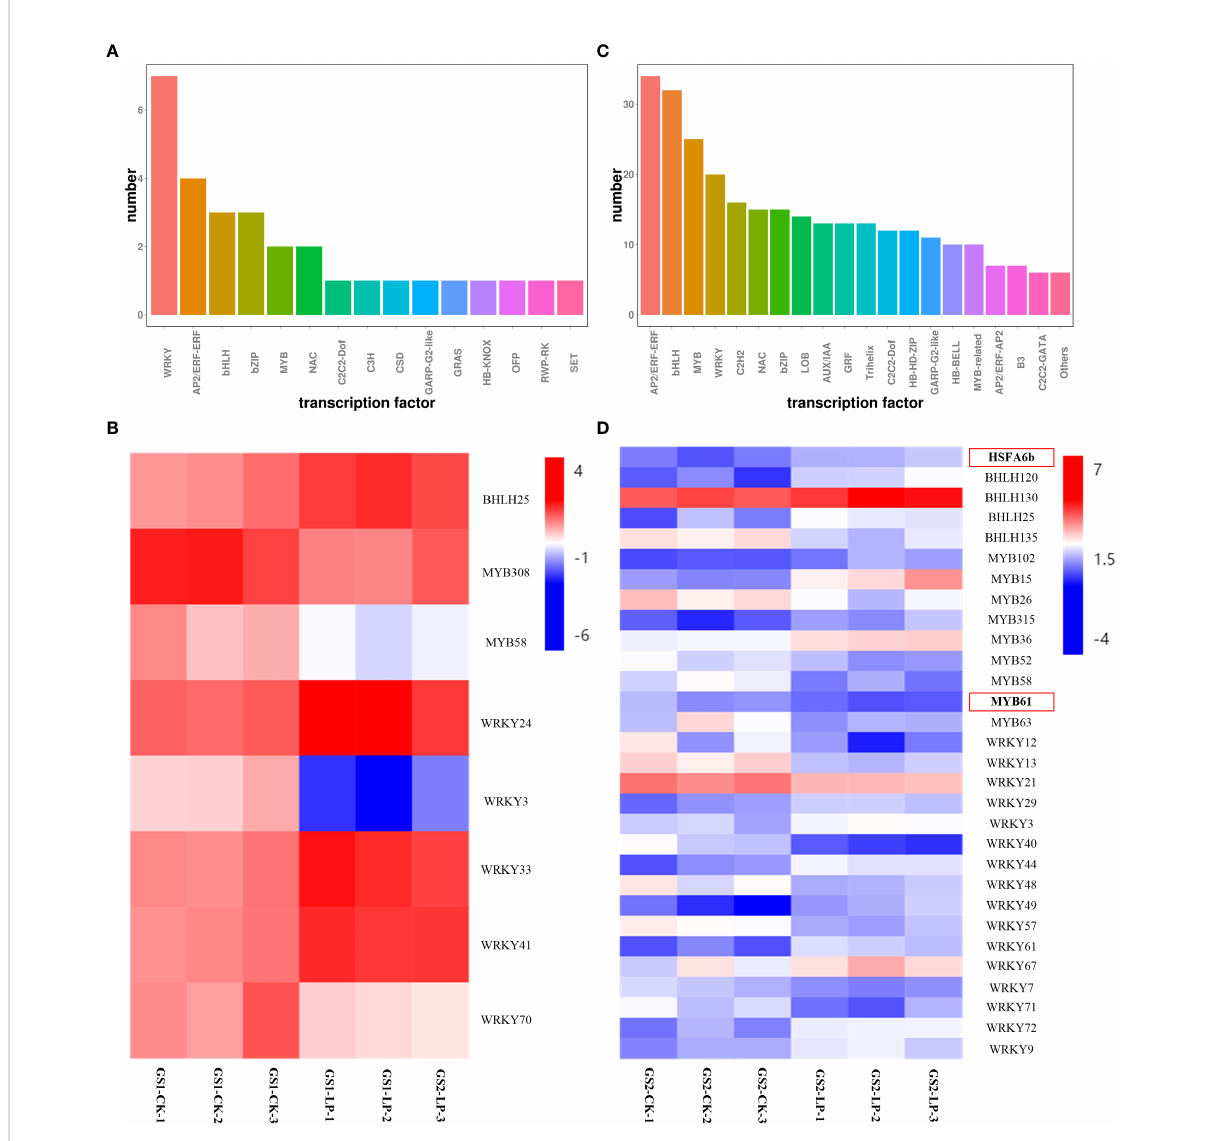
FIGURE 3 Differentially expressed transcription factor in roots of two ecotypes of wild soybean seedlings under control and low-phosphorus conditions. GS1, common wild soybean; GS2, barren-tolerant wild soybean; CK, control group; LP, low-phosphorus stress group. (A) Number of differentially expressed transcription factor in common wild soybean; (B) Regulation of the transcription factors in common wild soybean; (C) Number of differentially expressed transcription factor in barren-tolerant wild soybean; (D) Regulation of the transcription factors in barren- tolerant wild soybean. The expression levels represented as fold change; red indicates up-regulation; blue indicates